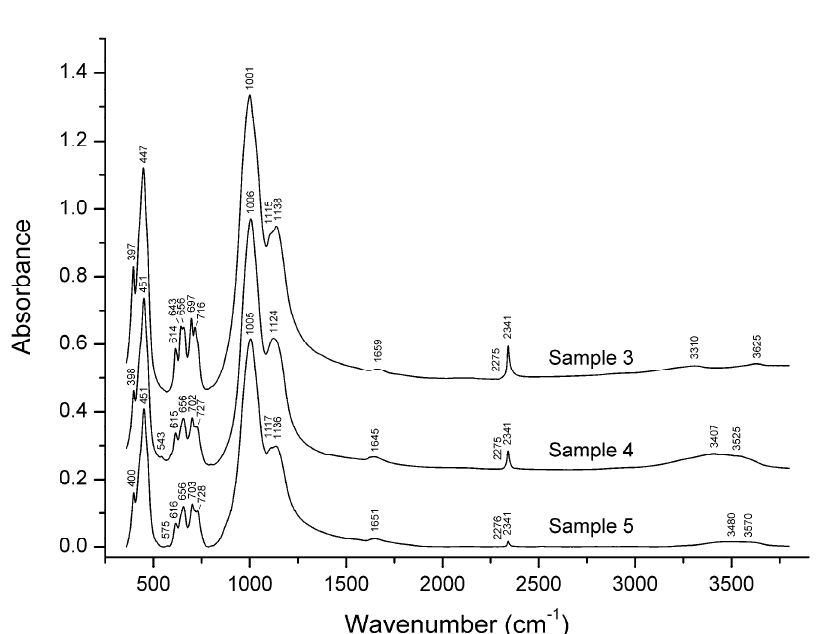
Figure 5. Infrared absorption spectra of sodalite and nosean (Samples 1 and 2).